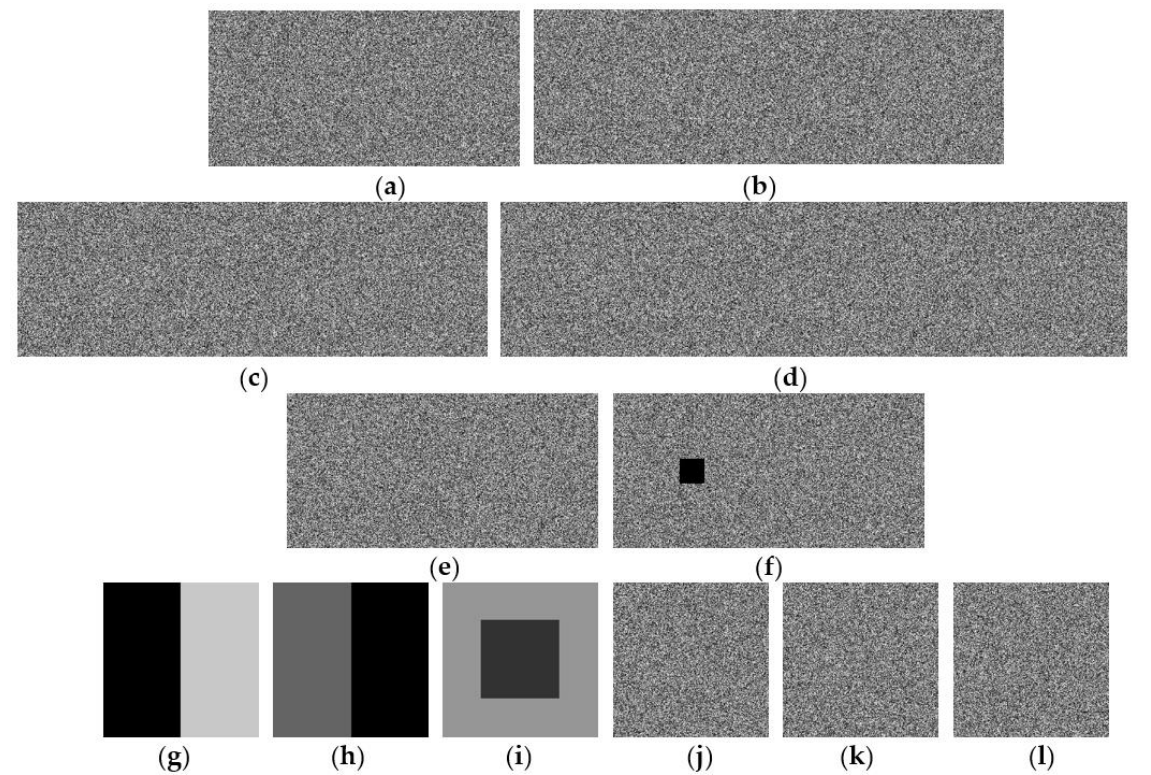
Figure 11. Results of the recovery of attacked shared images in the proposed (3,5,3) SRS method. ( a – e ): 5 shared images as in Figure 10d – h; ( f ) maliciously attacked shared image of ( a ); ( g – i ): 3 recovered secret images from ( a – c ); ( j – l ): 3 recovered secret images from ( f , b , c ).